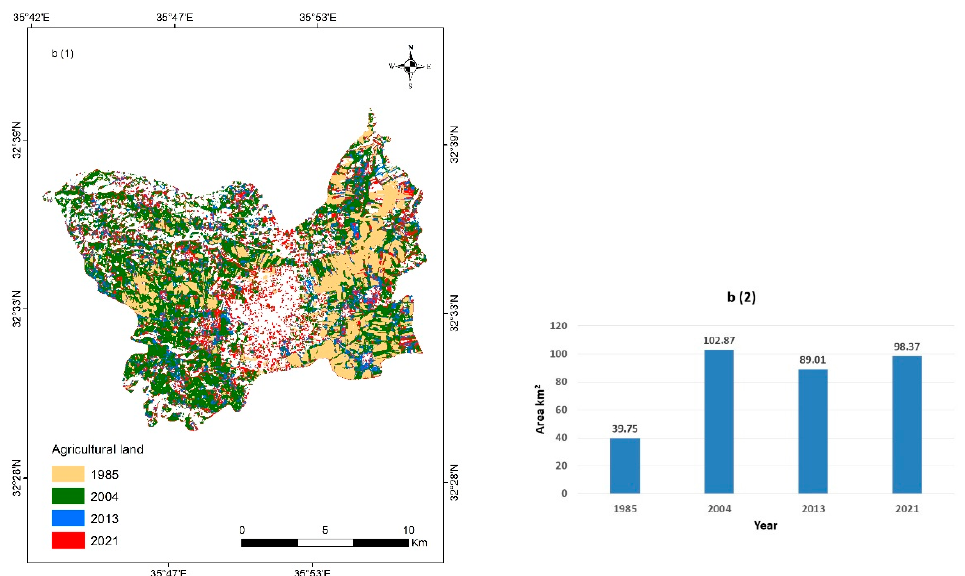
Figure 5. ( a1 ) urban extent; ( a2 ) the area of the urban area over the study period from 1985–2021; ( b1 ) agricultural land extent growth; ( b2 ) the area of agricultural land over the study period (1985–2021). Table 4. Irbid LULC (km 2 ) change computed four-time periods 1985–2021.